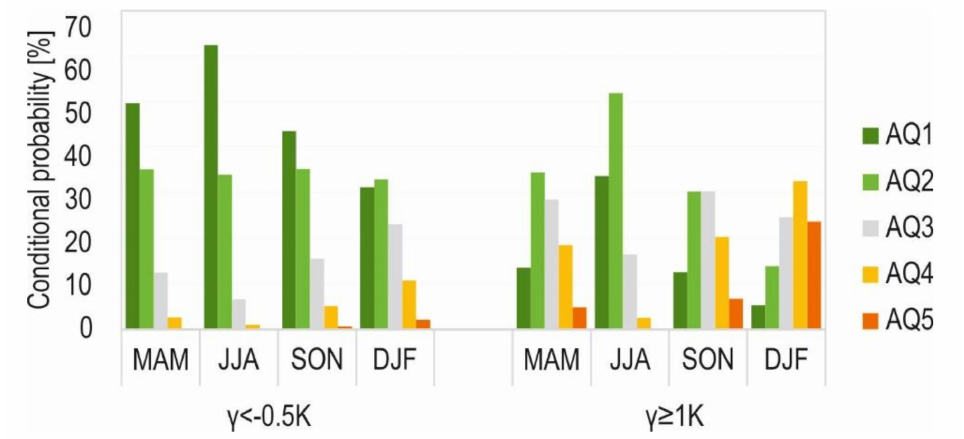
Figure 9. Average probability of air quality classes conditioned by strong and conditionally unstable ( γ ≤ − 0.5 K) and stable ( γ ≥ 1.0 K) atmospheres from seasonal perspective in GZM; average probability calculated from station probabilities; for example, AQ1 conditional probability for all unstable conditions was calculated as a quotient of the number of hours with AQ1 and the number of hours with γ < − 0.5 K in a given season and expressed in